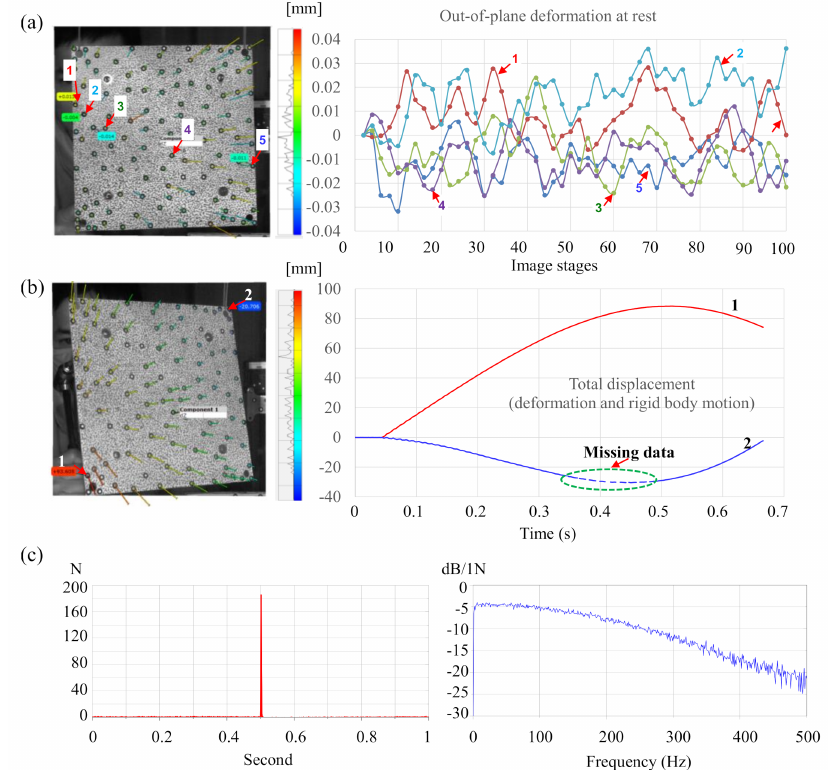
Figure 5. Out-of-plane deformations at rest and displacement at deformed stages: ( a ) out-of-plane deformation at rest, ( b ) out-of-plane displacements of two target points (1 and 2) including rigid body motion. Note: the dashed data of point 2 indicates several missing data, and ( c ) an impulse force history and its